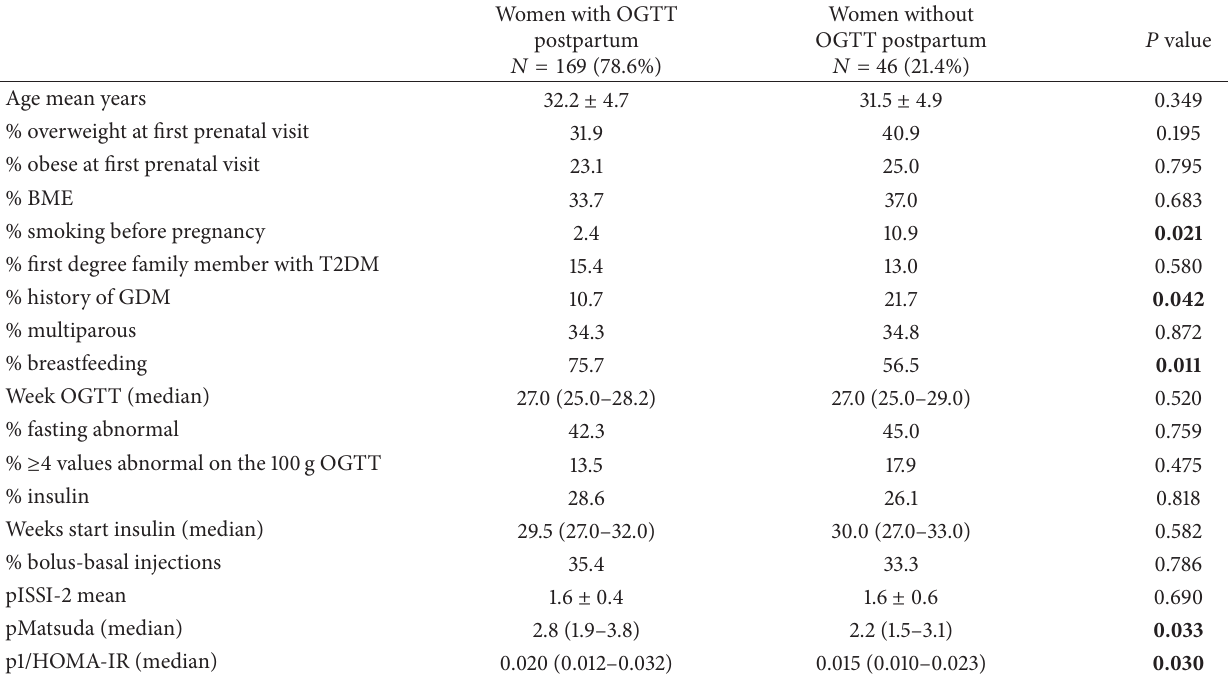
Table 1: Comparison of the characteristics between women who received an OGTT postpartum and women who failed to attend the scheduled OGTT